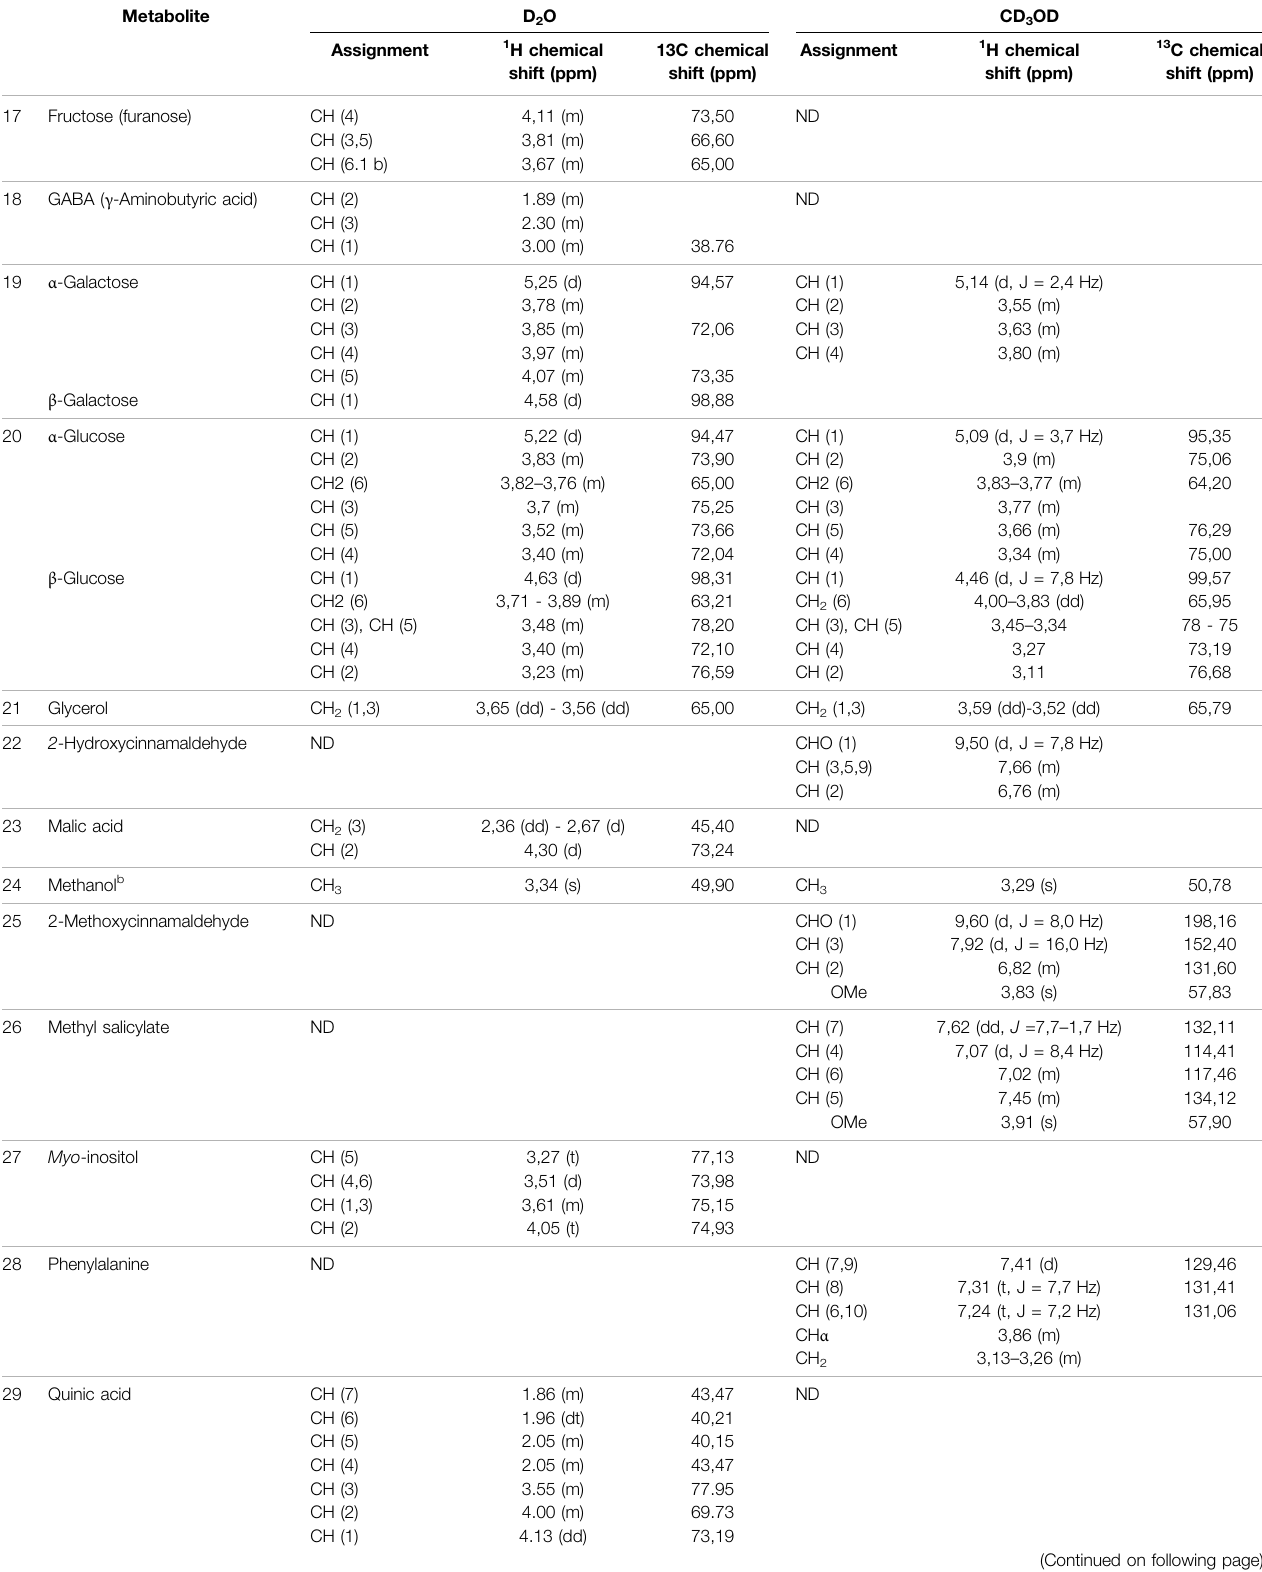
TABLE1| ( Continued )Assignmentsof 1 Hand13Cchemicalshiftsoftheresonancesofmetabolitescontainedincinnamonextractsasfoundin 1 H-NMR, 1 H, 1